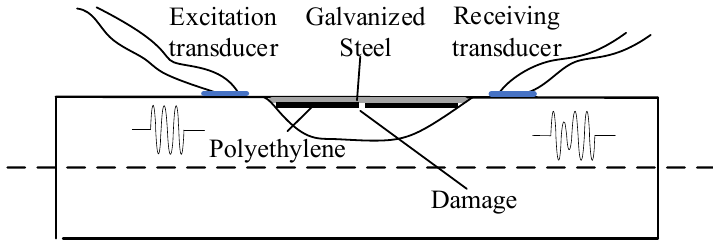
Figure 1. Schematic illustration of a nonlinear ultrasonic method for anti-corrosion pipes.